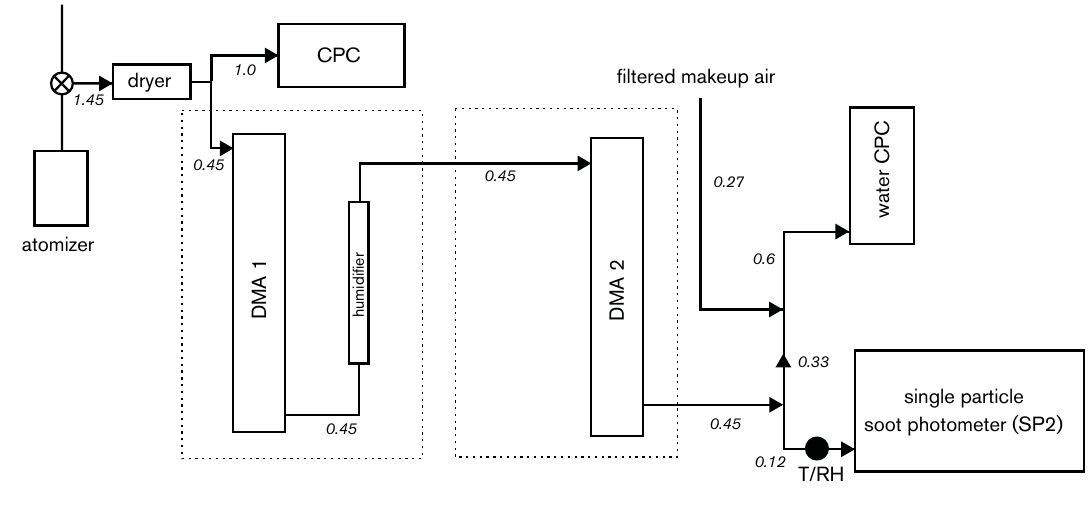
Fig. 1. Schematic of the instrument setup.